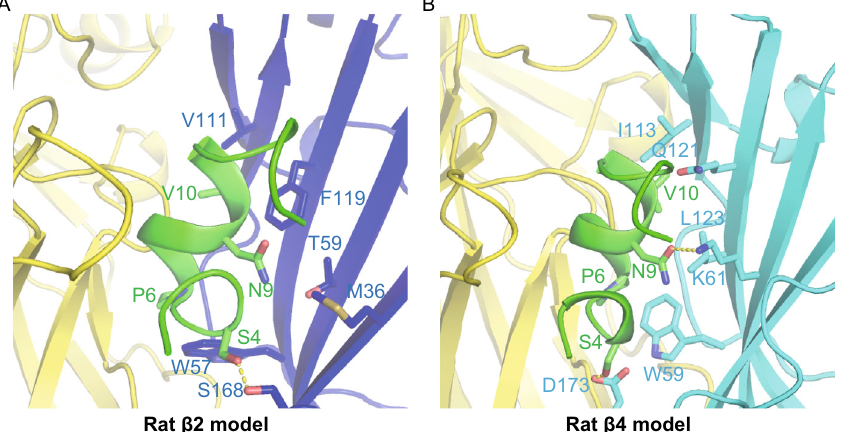
Figure 5. Homology modelling of rat β 2 and rat β 4 bound with α -conotoxin LvIA using Ac-AChBP/LvIA as the template. (A) In the rat β 2 homology model, Asn-9 resides in a hydrophobic pocket that is formed by Met-36, Thr-59, and Phe-119; Val-10 performs a hydrophobic interaction with Val-111. (B) In rat β 4 homology model, there is a little positional shift of Asn-9, making it form a hydrogen bond with Lys-61 but losing extensively hydrophobic interactions with Ile-123, Gln-121, and